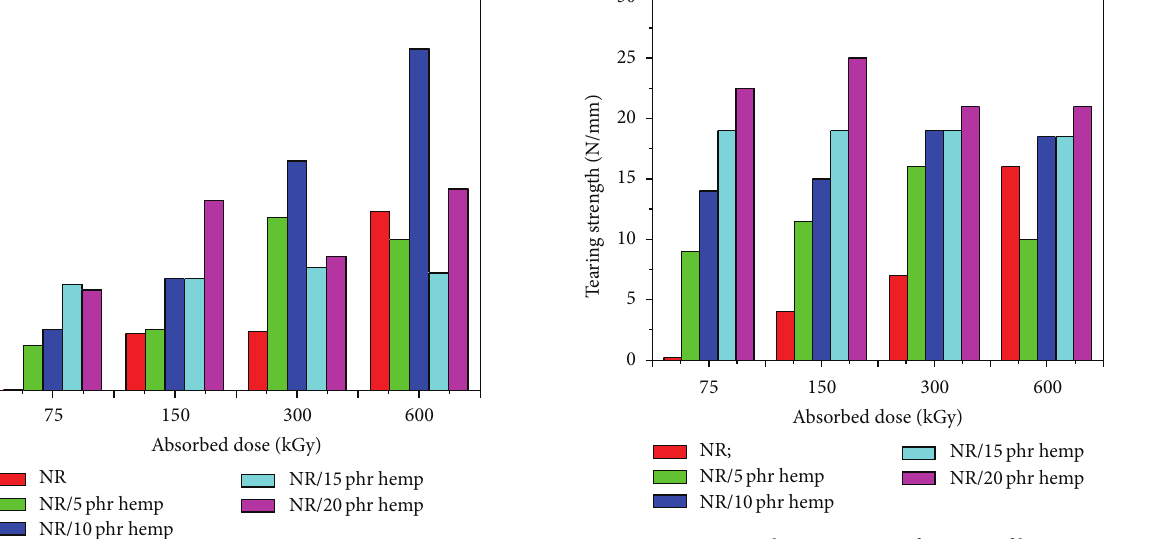
Figure 4: Tensile strength variation as a function of hemp amount and irradiation dose.